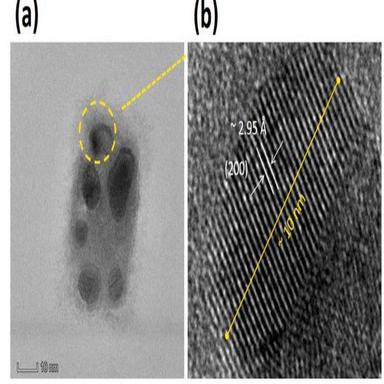
a) HRTEM image of MAPbBr3 powder perovskite, b) the interplanar spacing of 2.95 Å corresponding to the (200) plane of MAPbBr3 phase.